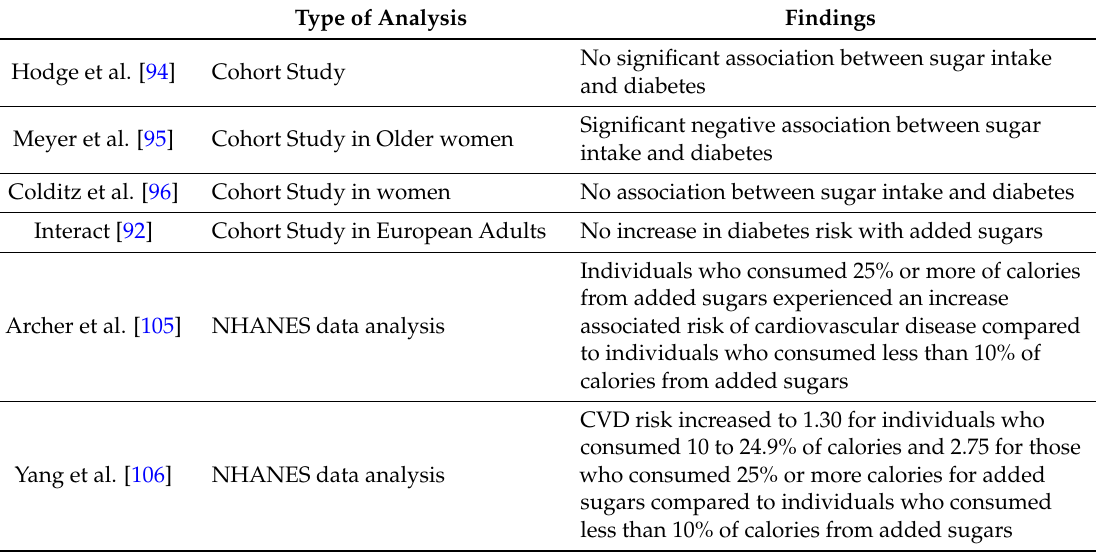
Table 3. Cohort Studies